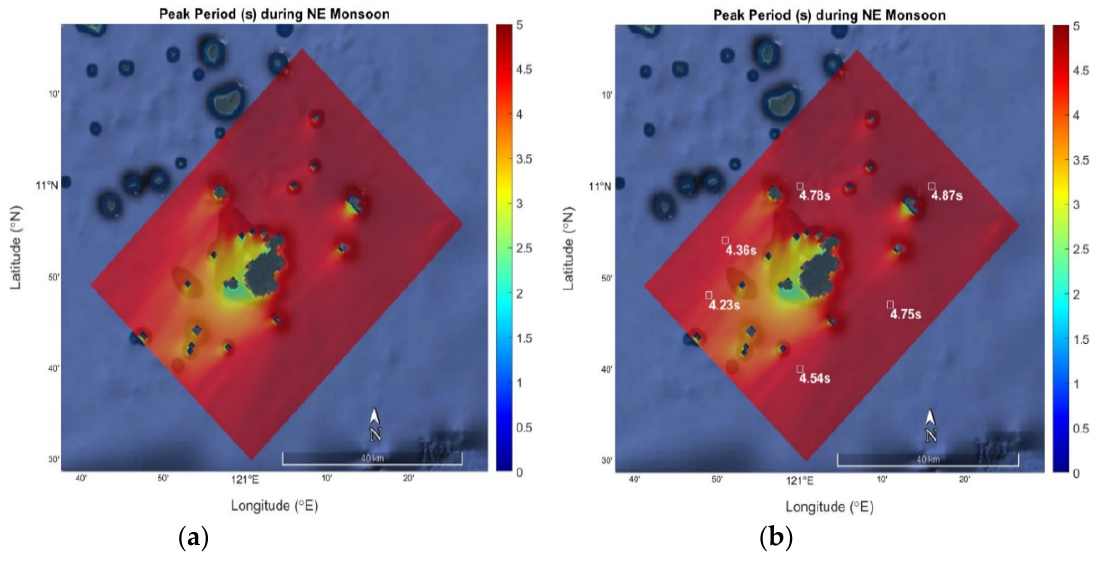
Figure 16. ( a ) T p (s) model during northeast monsoon season and ( b ) T p model indicating the average T p at stations A–F.